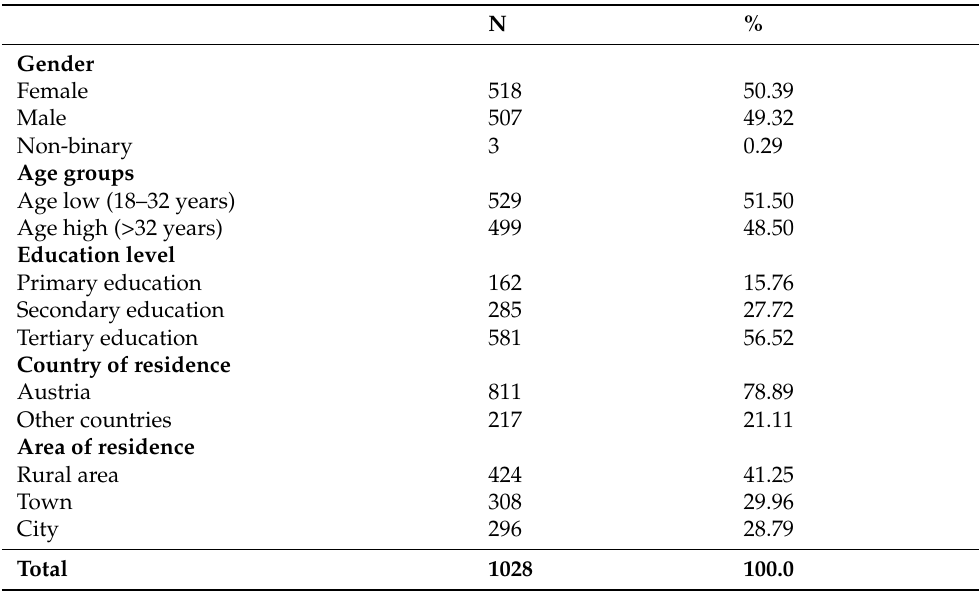
Table 1. Sociodemographic characteristics of the study population (n =